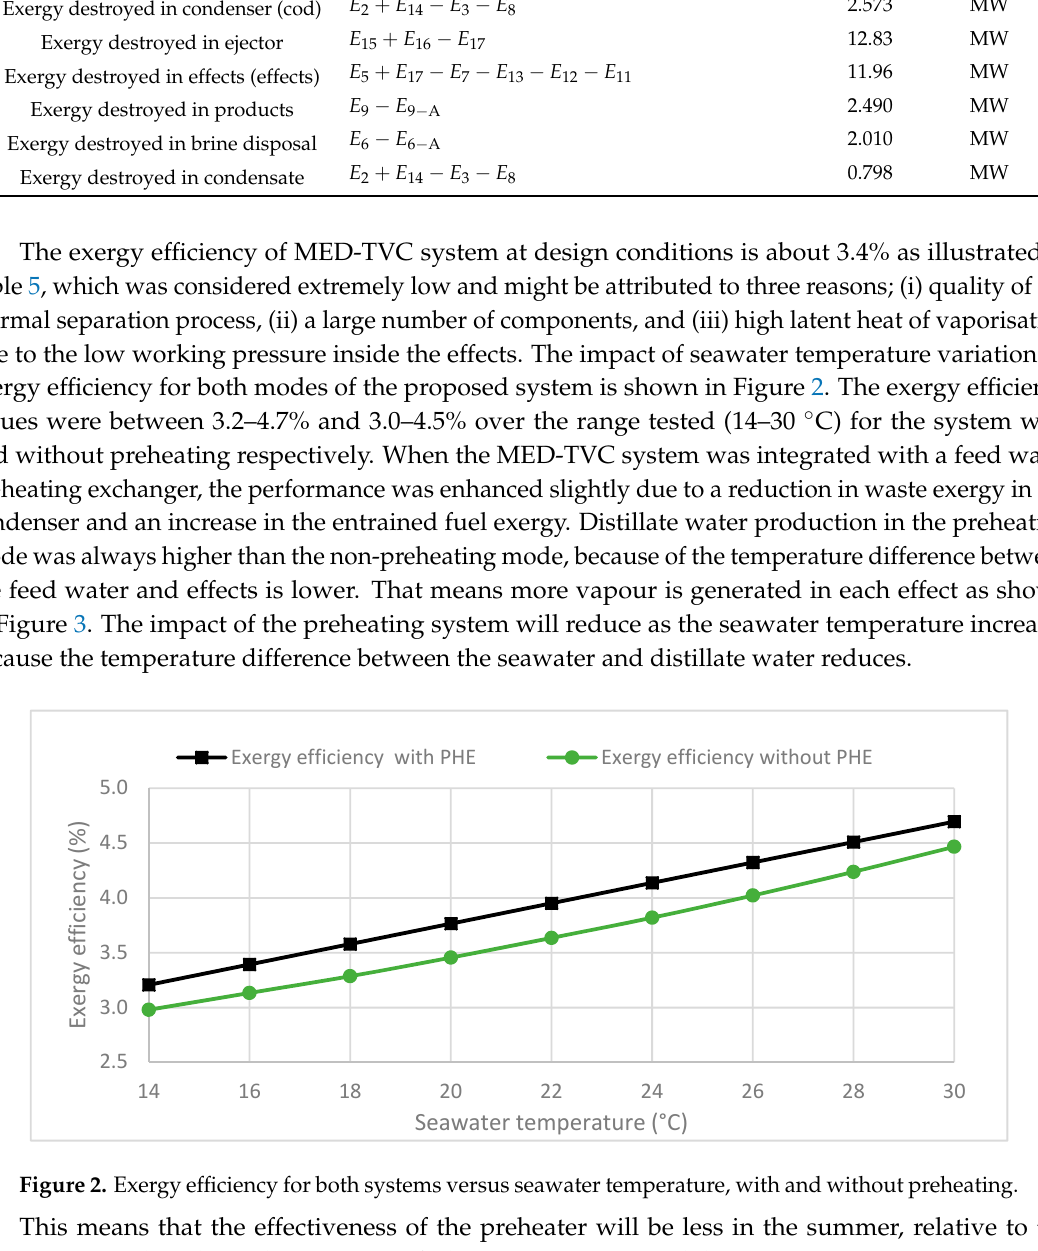
Figure 3. Distillate water production in tonne per hour for both systems versus seawater temperature. This means that the effectiveness of the preheater will be less in the summer, relative to the winter season. The relation between specific heat consumption and the seawater temperature is shown in Figure 4. The specific heat consumption is the amount of energy consumed to produce 1 kg of distillate water. The rate of increase in distillate water production is higher than the rate of increase of energy consumption, and that means there is a significant reduction in specific heat consumption and improvement in the MED-TVC gain ratio. In MED-TVC thermal desalination technology, the entrainment ratio (ratio of motive steam mass flow rate to the mass of entrained vapour) is considered an important factor in determining energy input and plant size. A thermo-compressor compresses the entrained vapour which is mixed with motive steam then directed to the first effect in the MED-TVC unit. The entrained vapour represents only a small portion of the vapour generated in the last effect, while the remaining vapour moves forward to the condenser to continue the process .